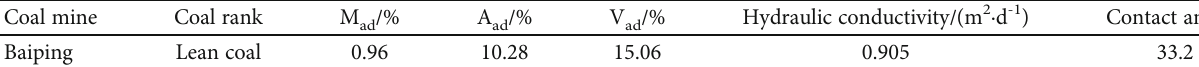
Table 1: Industrial analysis results of raw coal.